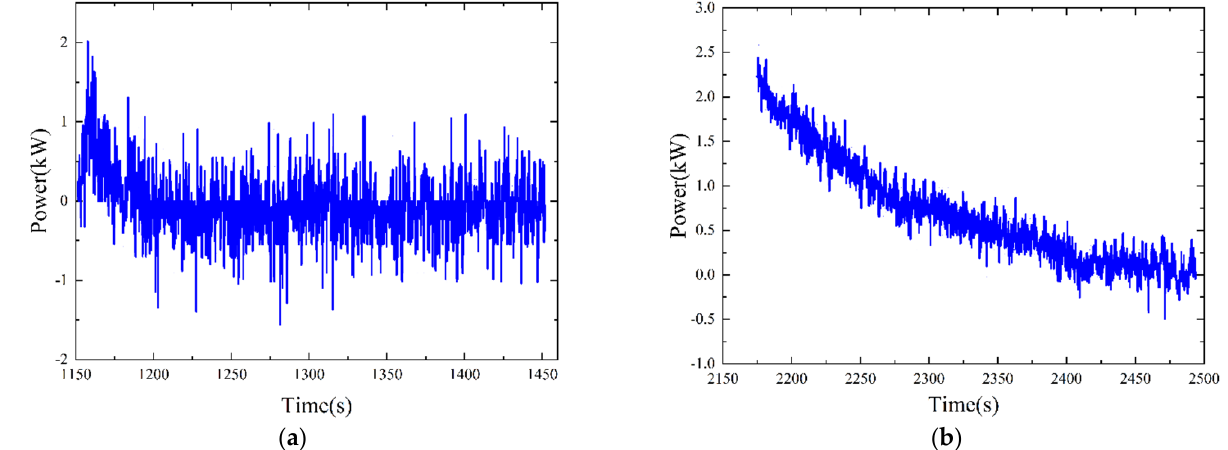
Figure 6. Vehicle speed, fuel cell stack power, and power battery power in constant power mode: ( a ) Vehicle A; ( b ) Vehicle B.